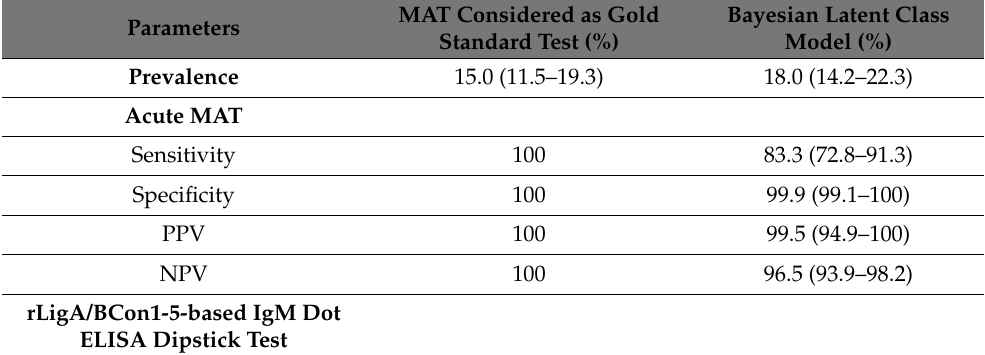
Figure 3. Recombinant LigA/BCon1-5 antigen-based latex agglutination test (LAT) for detection of anti-leptospiral antibodies in human sera. ( A ): Negative sera showing homogenous suspension ( B ): Human sera which showed seroconversion (0 to ≥ 100) giving a LAT score of 1+ve, ( C ): Human sera which showed a four-fold rise in the MAT titre ( ≥ 50 to ≥ 200) giving a LAT score of 2+ve, ( D ): Human sera which showed a positive reaction in the single acute MAT (MAT titre ≥ 400) giving a LAT score of 3+ve.